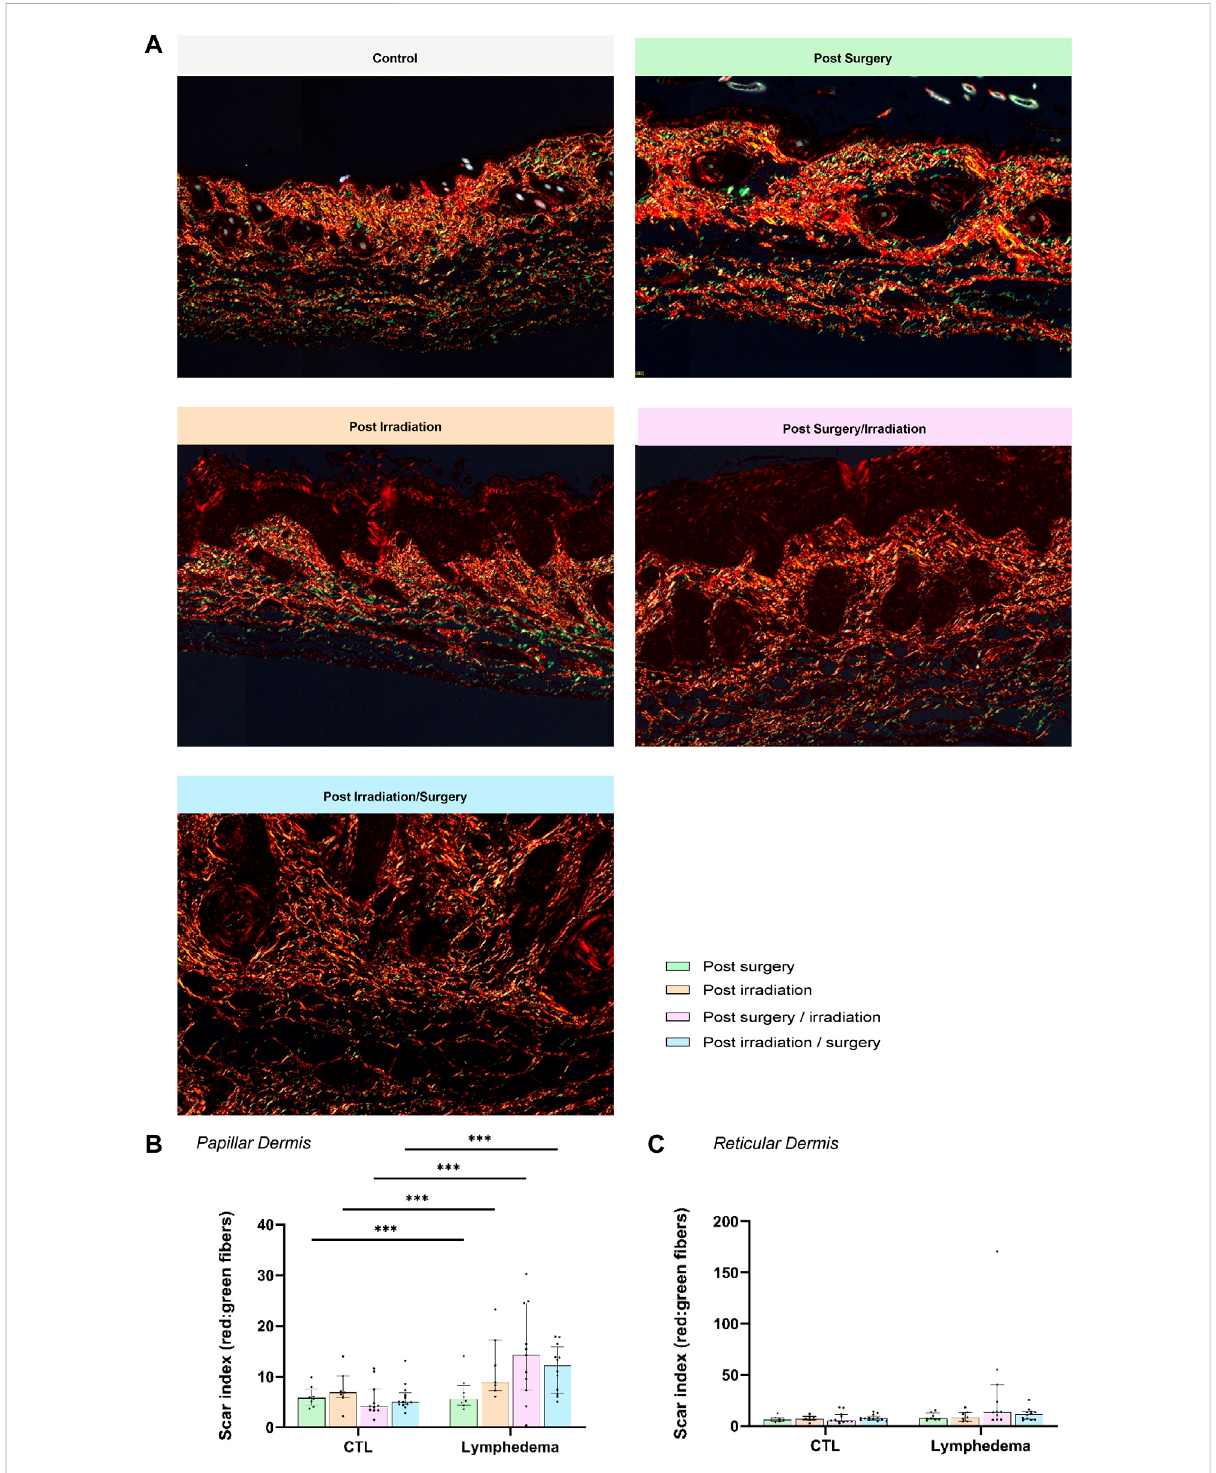
FIGURE 5 Impact of the procedures on collagen deposition. (A) Representative images of red Sirius visualized through polarized light in control and LD skins(Scalebar:200 µm). (B) and (C) ScarIndex(red/greenstaining ’ s)calculatedthroughcomputerizedmethodinPD (B) andRD (C) .Thedottedline delineates the junction between PD and